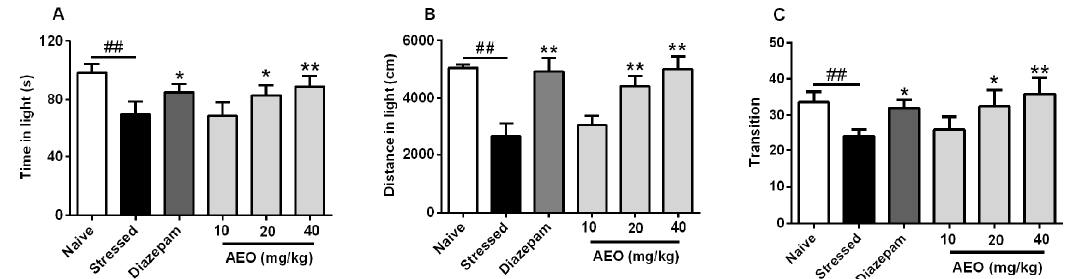
Figure 2. Effects of AEO on restraint stress-induced anxiety as shown by the light dark exploration (LDE) test. All mice except for the naive group received 10 days restraint stress, then ( A ) time, ( B ) distance, and ( C ) transition in light compartment were recorded during a 5 min test period. Each value represents the mean ± SEM with n = 12, ## p < 0.01 vs. the naive group, * p < 0.05 and ** p < 0.01 vs. the stressed group.